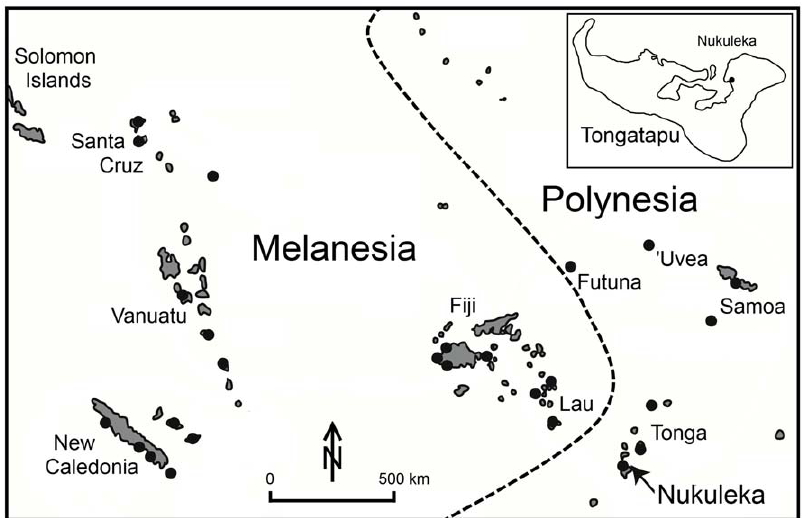
Figure 1. Lapita site distribution in Remote Oceania. Black dots represent Lapita sites or site concentrations. Nukuleka occurs on the southern island of Tongatapu, Kingdom of Tonga. The Nukuleka site map is provided as Figure S1.